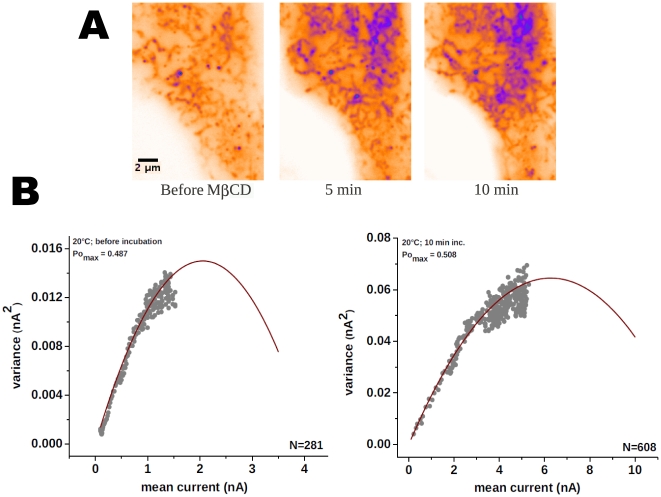
The effect of methyl-beta-cyclodextrin (MβCD).
A, Images representing overall activity after 200 frames (addition of all frames). Blue shade spots represent higher intensity, therefore an augment in vesicle residency over the recording. A 5 minutes treatment is enough to augment TRPM8-EGFP density at the plasma membrane. B, Variance analysis made on HEK293 cells stable expressing TRPM8 channels showing an increase in the average current correlated with a three fold increment in the number of active channels at the membrane (n = 4).